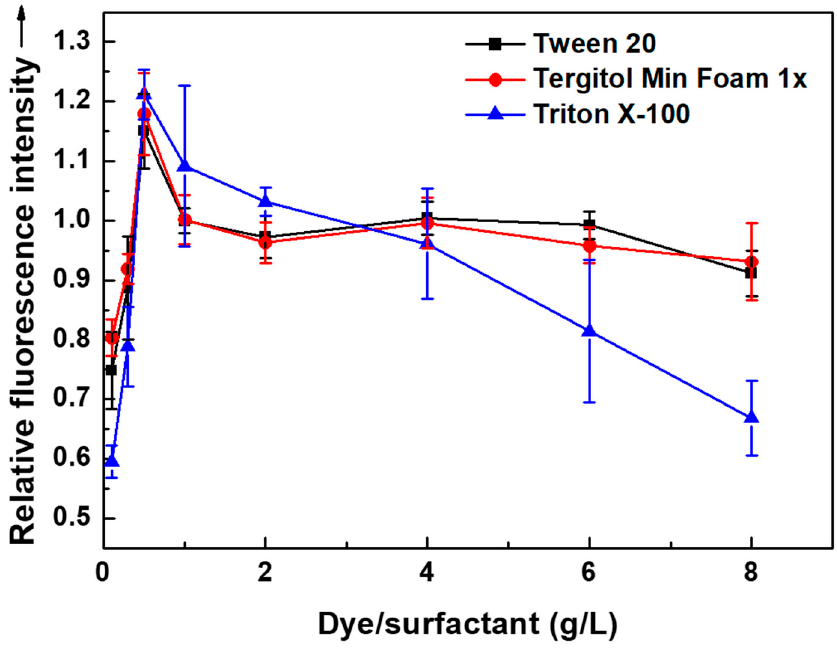
Figure 5. Relative fluorescence intensity of PP MPs stained with different surfactants at different dye/surfactant ratios. Staining conditions: dye = S-FN; dye/MP = 2.5 wt%; MP/aqueous solution = 1 g/L; staining time = 60 min; staining temperature = 80 °C.